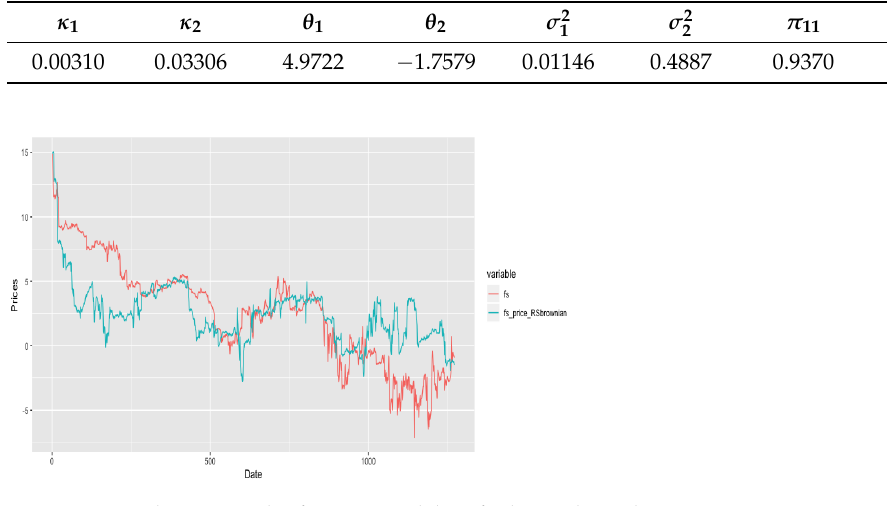
Figure 5. Simulation Result of RSOU model on fuel-switching